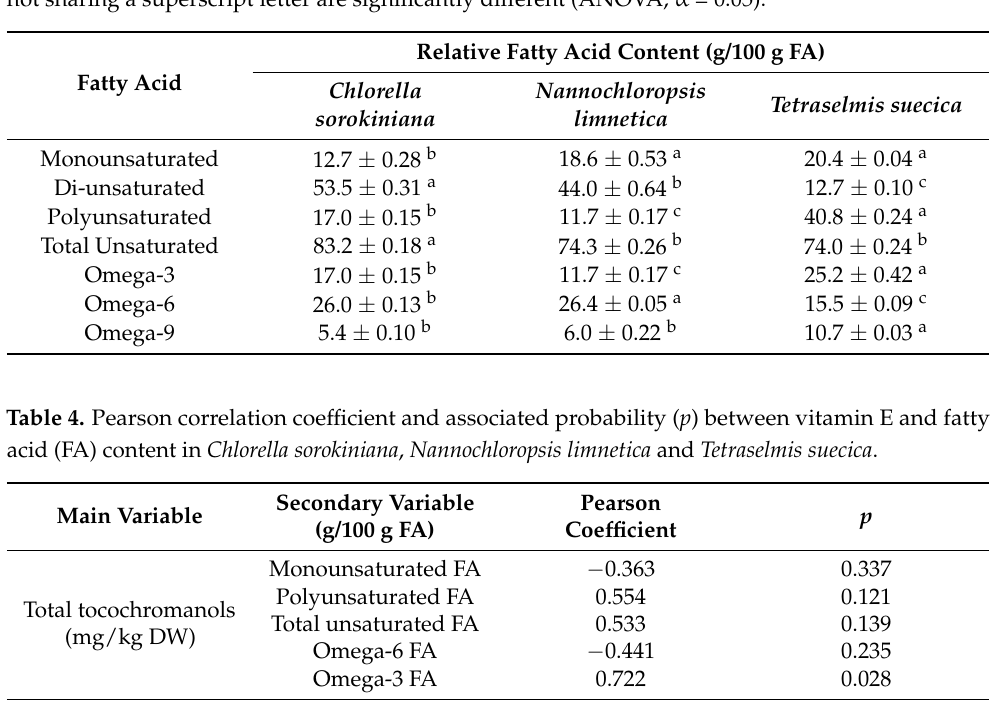
Table 3. Relative fatty acid content (percentage of total fatty acids (g/100 g FA)) in Chlorella sorokiniana , Nannochloropsis limnetica , and Tetraselmis suecica determined by GC-MS as FAME ( n = 3). Fatty acids not sharing a superscript letter are significantly different (ANOVA, α = 0.05).